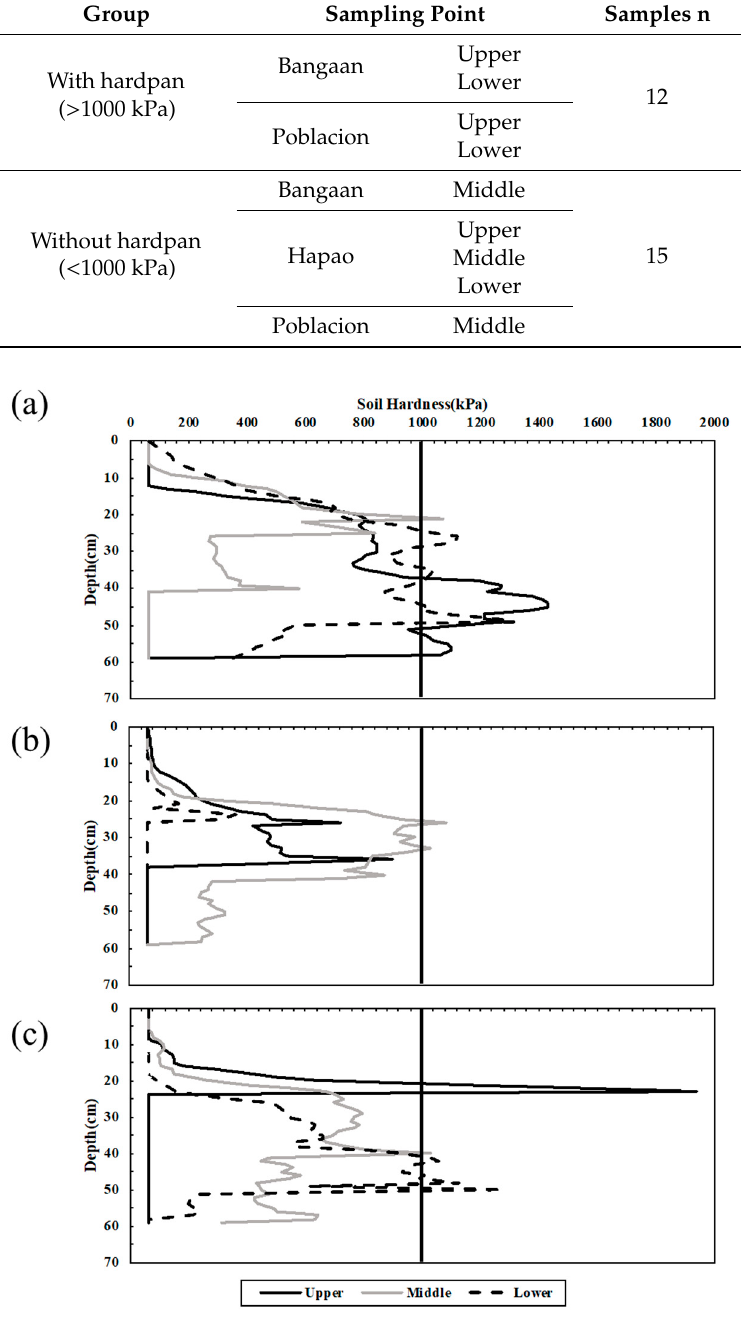
Figure 3. Soil hardness profile (kPa) ( a ) Bangaan, ( b ) Hapao, and ( c ) Poblacion.